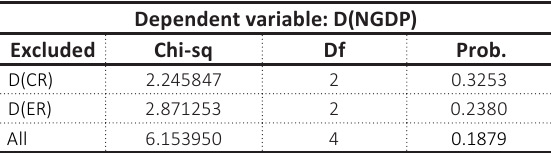
Table 3. The results of the Granger causality test